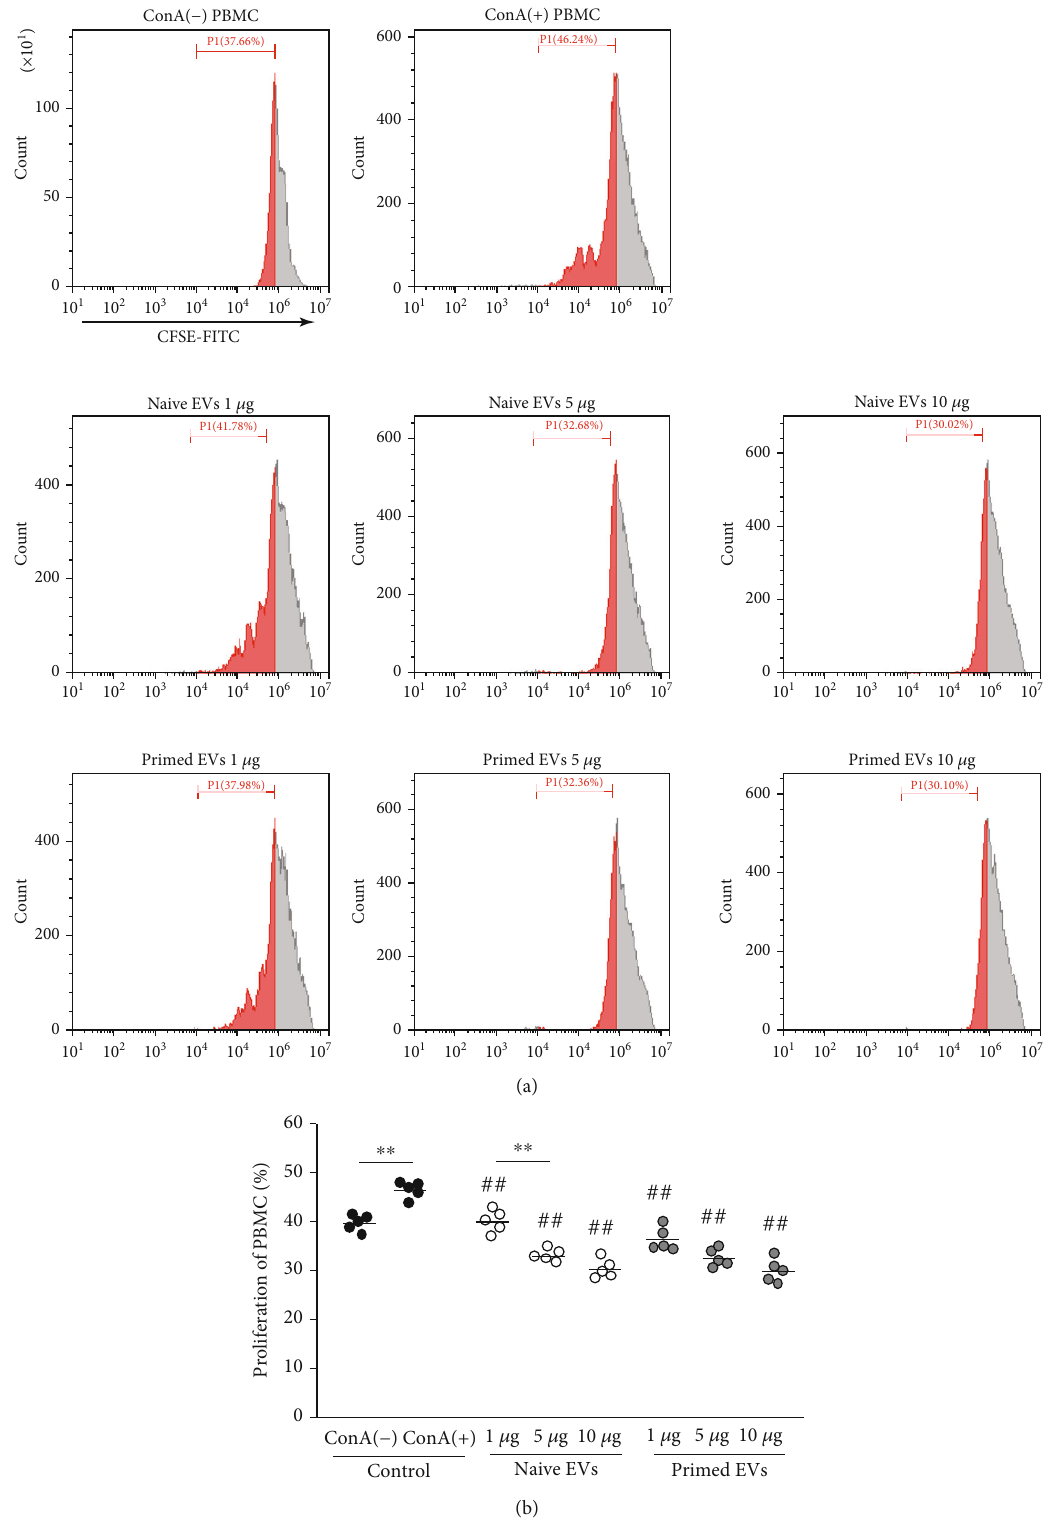
Figure 3: Proliferative ability of PBMCs cocultured with cADSC-EVs. (a) Proliferation of PBMCs was assayed using the CFSE method by fl ow cytometry. Segments represent the percentages of PBMC proliferation. (b) Comparison of proliferative PBMCs treated with various concentrations (1, 5, and 10 μ g/ml) of naive or primed cADSC-EVs. The inhibitive e ff ects on PBMCs were not di ff erent between naive and primed EVs at the same concentrations. The solid line indicates the average. ## P < 0 : 01 vs. PBMCs stimulated with ConA. ∗∗ P < 0 : 01 , between